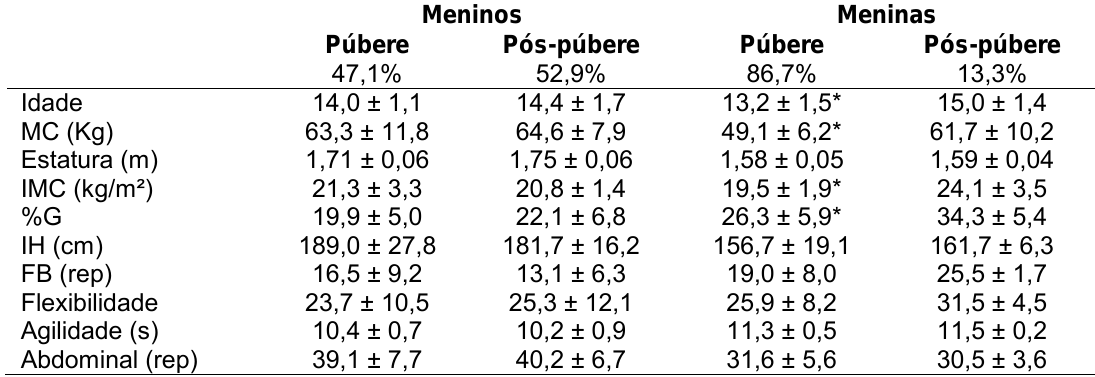
Tabela 2. Freqüência de indivíduos púberes e pós-púberes e as médias e desvios padrão das características antropométricas e das variáveis do desempenho motor, entre os diferentes